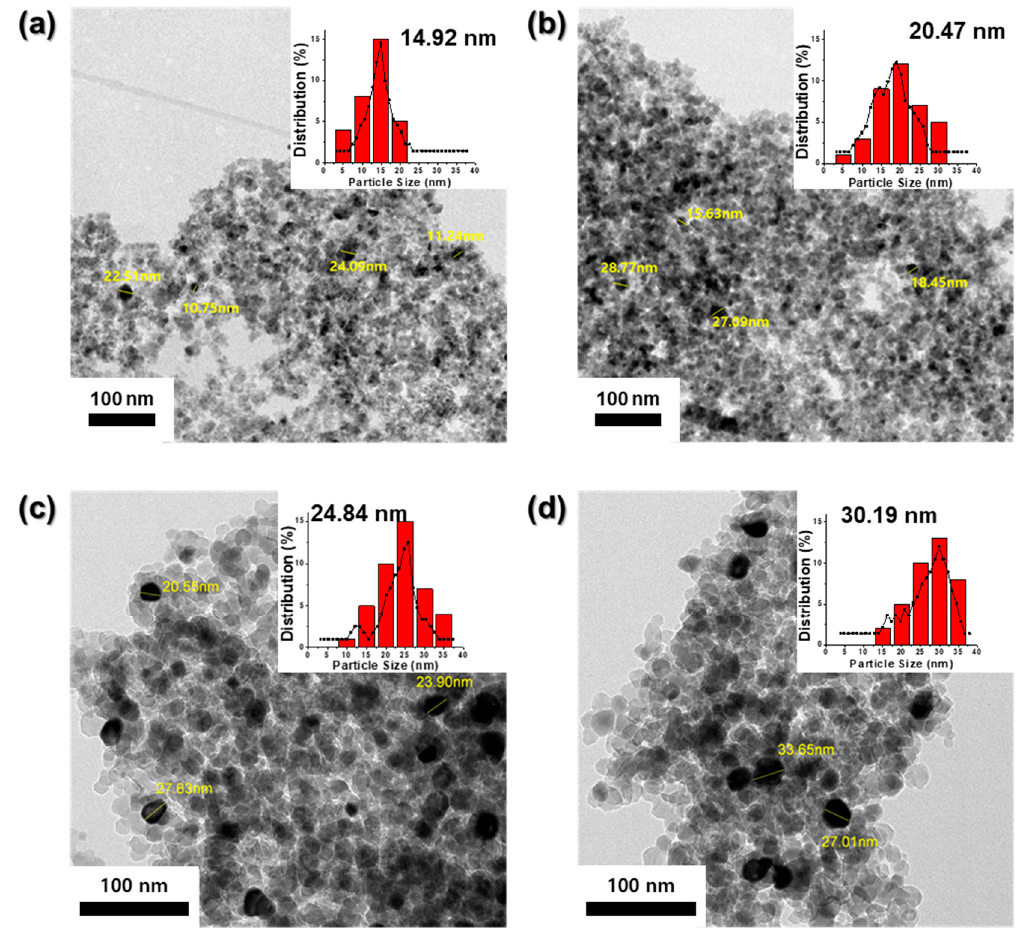
Figure 4. TEM images and Ni particle size distributions of ( a ) Ni/Mg9, ( b ) Ni/Mg19, ( c ) Ni/Mg25 and ( d ) Ni/Mg30 after reduction at 800 °C for 2 h.